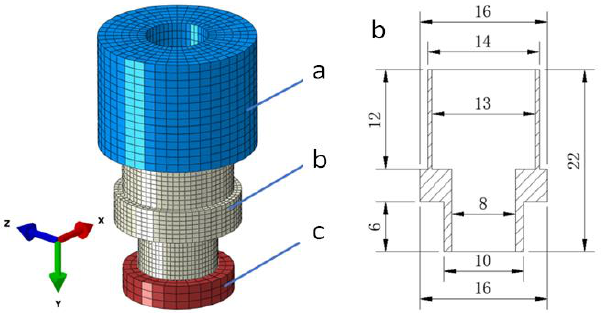
Figure 1. Finite element model for the spacing shim’s nosing. a — Nosing die; b — spacing shim; c — fixed die. (Unit: mm).